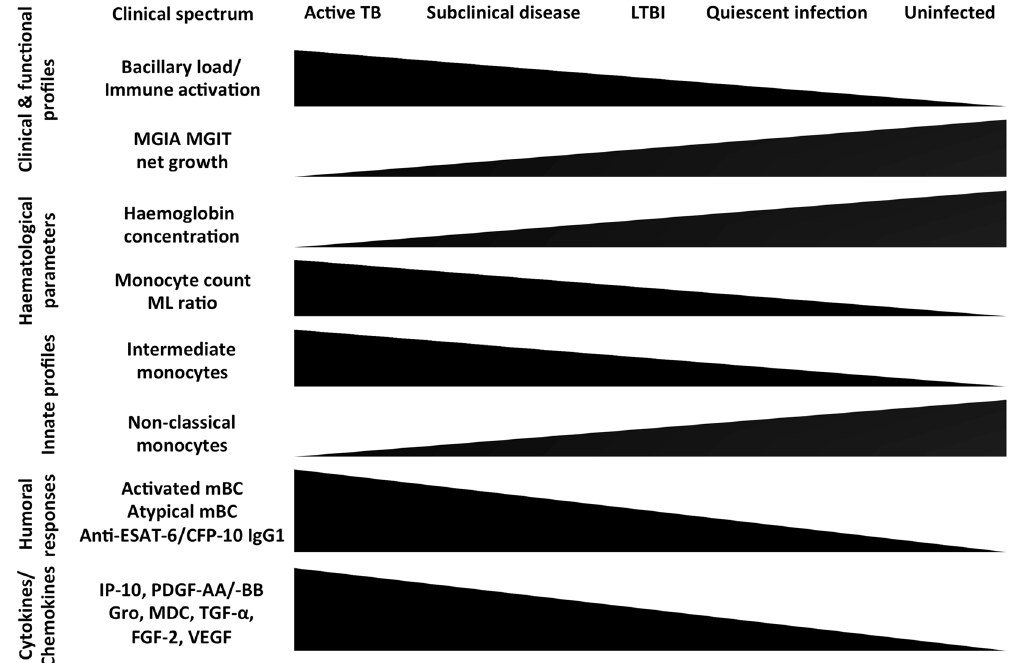
Figure 7. A spectrum of M . tb infection and associated immune profiles. We propose that the delineation of the spectrum of M . tb infection identified by the MGIT MGIA, and the underlying immunological profiles associated with this spectrum, is biologically plausible and may have value in identifying subclinical active TB disease and possibly in determining reactivation risk of